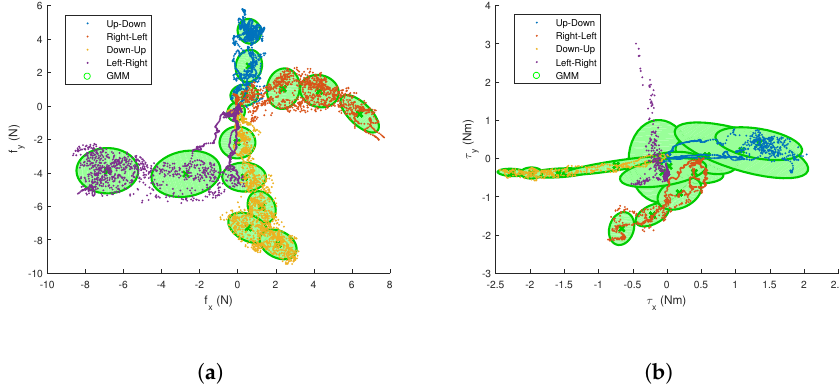
Figure 8. GMM encoding for the surface contact ( a ) and lever effect ( b ) gestures showing the fit of the training sequences with the generated Gaussians. The colored points represent the training measurements for each